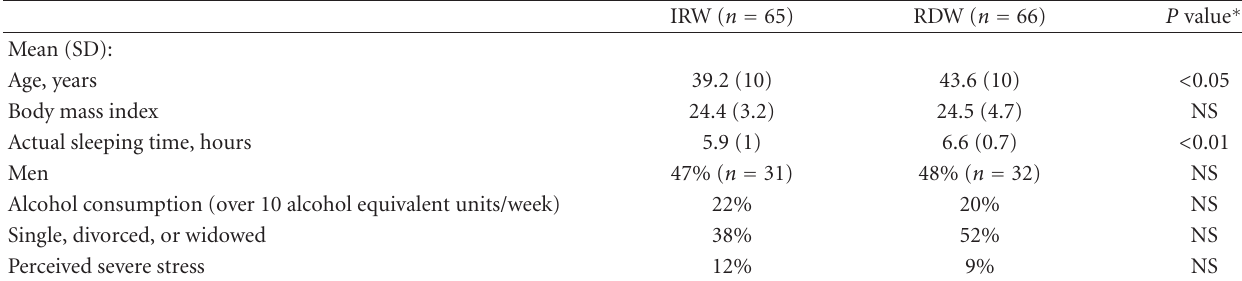
Table 1: Characteristics of media workers with or without irregular shift work.